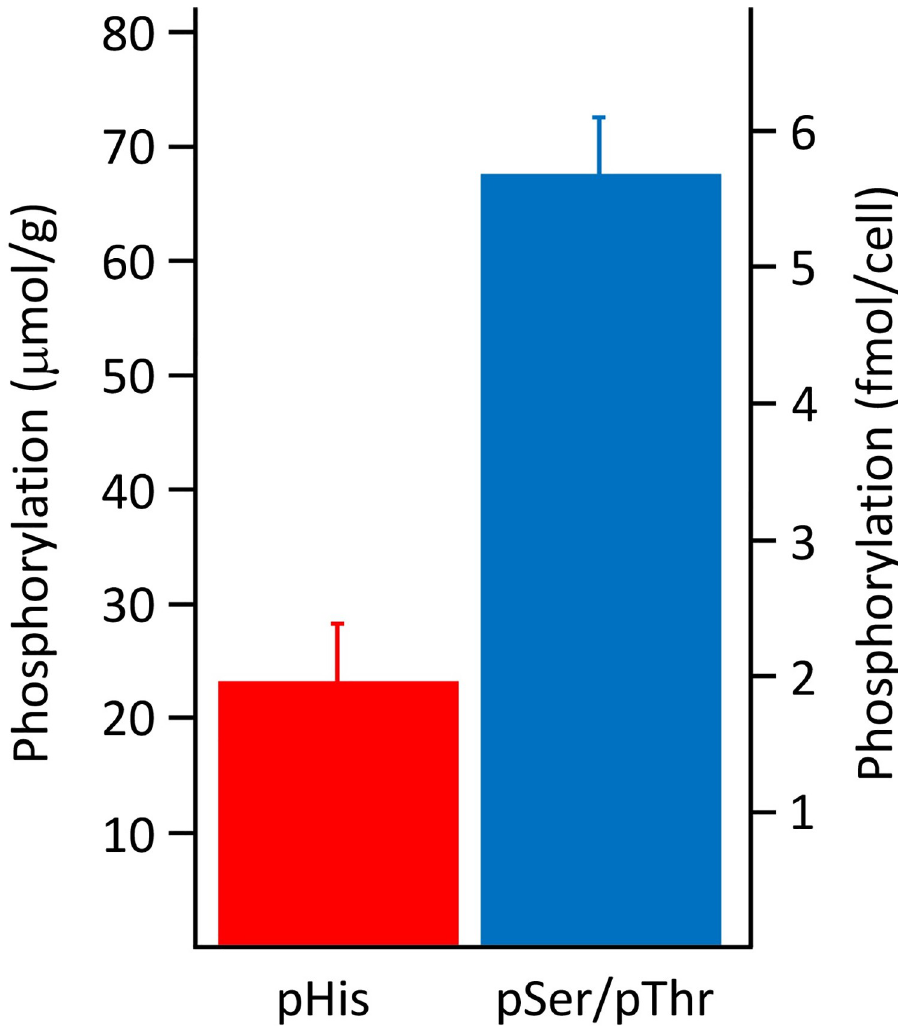
Fig 4. Quantification of pHis and pSer/pThr in 16HBE14o- cells using 31 P NMR spectroscopy. Error bars show the standard error of the mean ( n = 3).